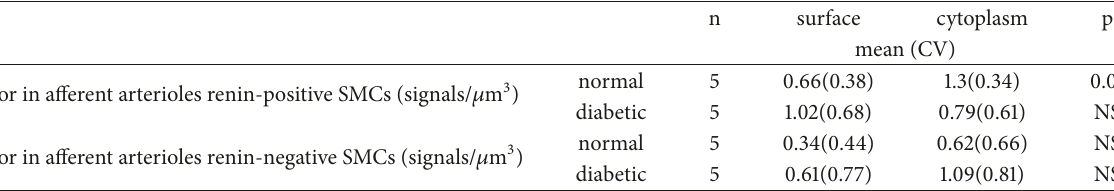
Table 5: The number of renin receptors on the surface and in the cytoplasm of renin positive and renin negative SMCs.